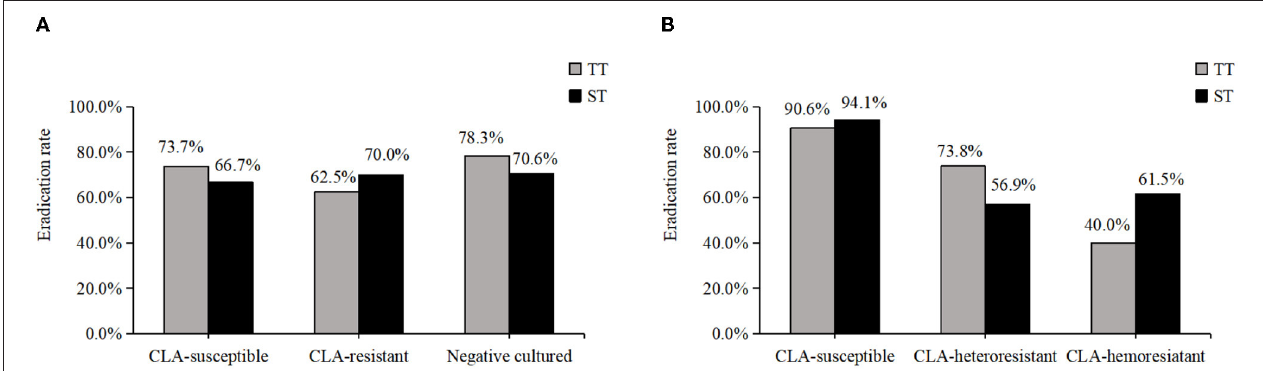
FIGURE 2 | The eradication rate of H. pylori based on phenotype and genotype. (A) The eradication rate of CLA-susceptible, CLA-resistant and cultured negative strains in phenotype. (B) The eradication rate of CLA-susceptible, CLA-heteroresistant and CLA-hemoresistant strains in genotype.